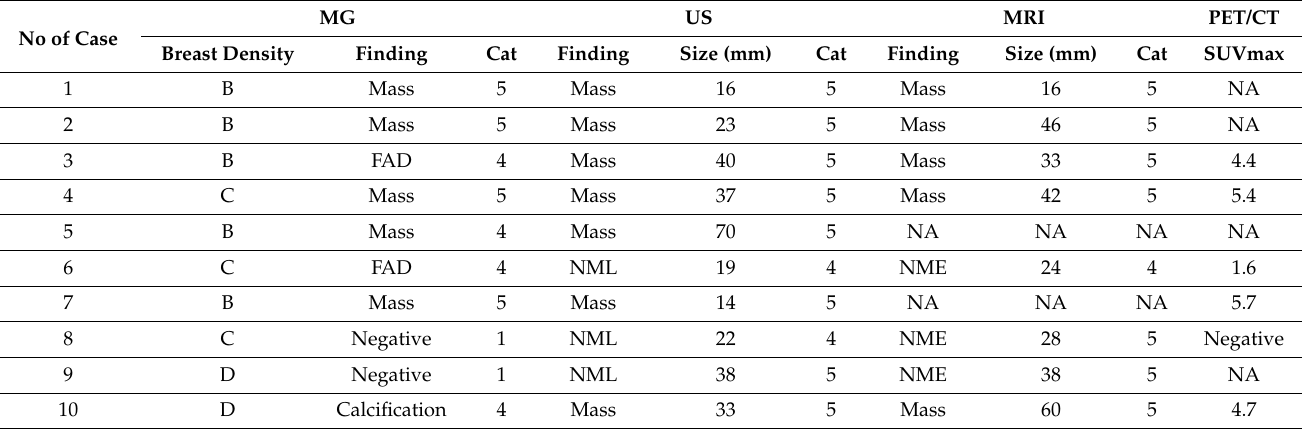
Table 2. Image findings of MG, US, MRI, and PET/CT of the patients.